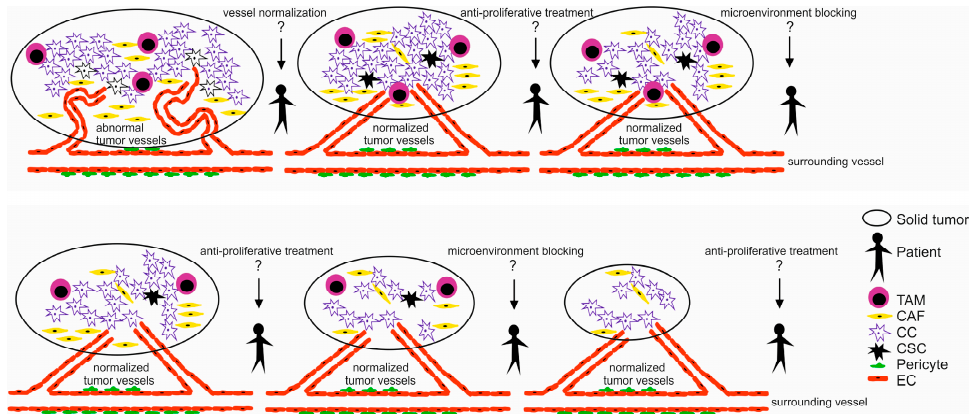
Figure 2. Proper scheduling of solid tumor treatment? Anti-cancer therapy should involve combination of anti-angiogenic (vessel normalization), anti-TME (eliminating cancer stem and progenitor cells) and anti-proliferative therapies (eliminating quickly dividing cancer cells). However, an optimal scheduling of combination therapies is still not known since a complex treatment strategy could result in an improved patient survival (tumor-associated macrophage (TAM), cancer-associated fibroblast (CAF), cancer cell (CC), cancer stem cell (CSC), endothelial cell (EC).